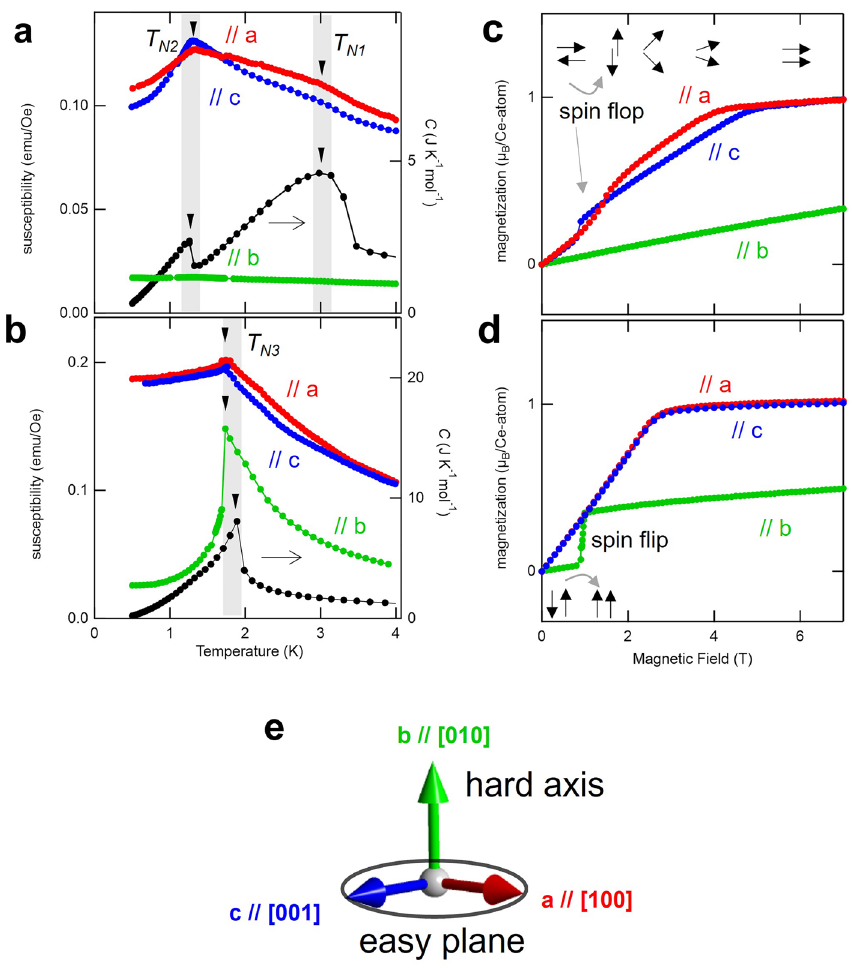
Figure 2. Magnetism and heat capacity characterization for CeTe 3 and CeSeTe 2 samples. ( a, b ) Temperature dependence of the magnetic susceptibility (right axis) for ( a ) CeTe 3 and ( b ) CeSeTe 2 with applying external field H = 0.1 T. On the right axis, temperature dependence of the heat capacity C ( T ) is also shown. In ( a ) and ( b ), there is slight difference in transition temperature since different samples were used for magnetic and heat capacity measurements. ( c , d ) Magnetic field dependence of the magnetization for ( c ) CeTe 3 and ( d ) CeSeTe 2 at T = 0.5 K. Cartoons for the magnetization process with spin-flop along easy plane and spin-flip along hard axis are shown in ( c ) and ( d ), respectively. The red, blue, and green data shown in ( a – d ) are obtained for H // a, H // c, and H // b, respectively. ( e ) The experimentally determined magnetic hard axis and easy plane together with crystal axes. These crystallographic and magnetic directions are the same for all samples shown in this